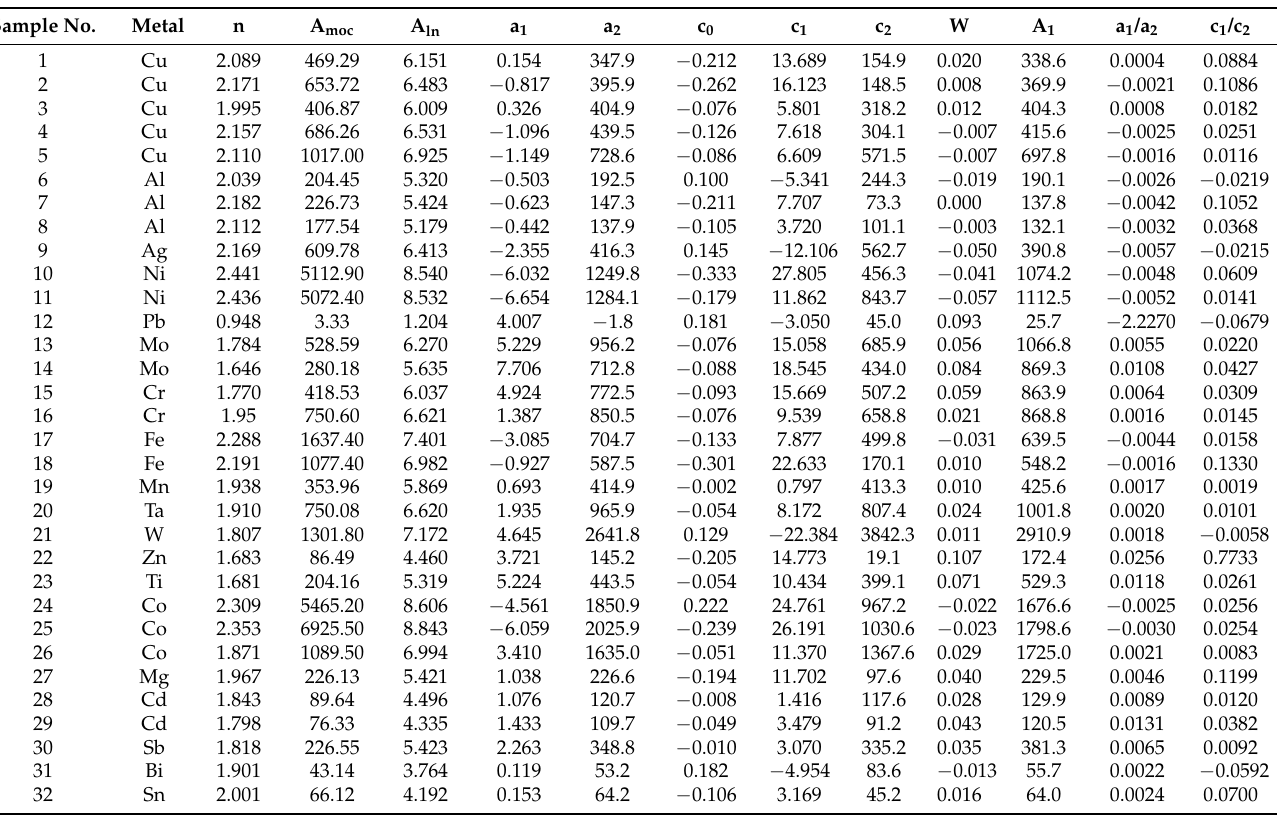
Table 4. The parameters of the